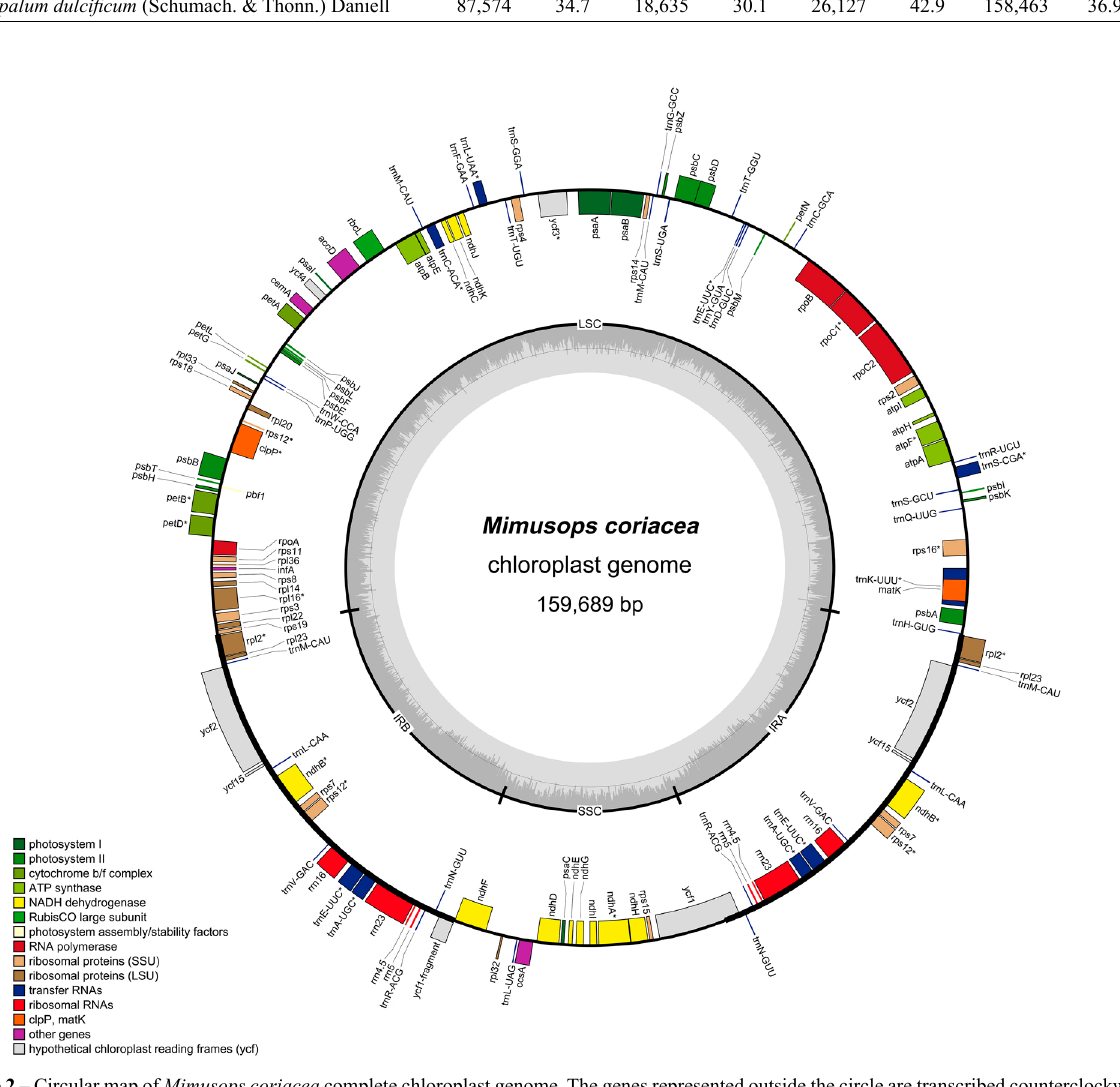
Figure 2 ‒ Circular map of Mimusops coriacea complete chloroplast genome. The genes represented outside the circle are transcribed counterclockwise and those inside the outer circle are transcribed clockwise. Genes are colored according to their functional groups following the legend. The inner gray graphs indicate the GC content across the